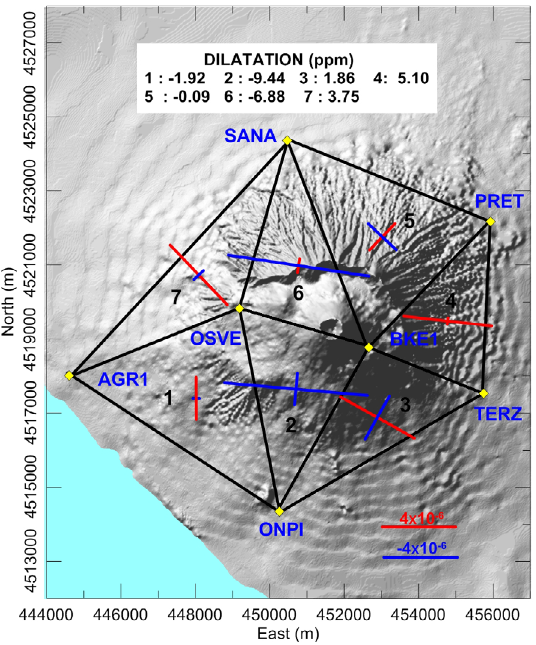
Figure 8. Principal strain axes for each of the seven triangles in which Vesuvius area has been divided. In the insert the dilatation values (in ppm) are also